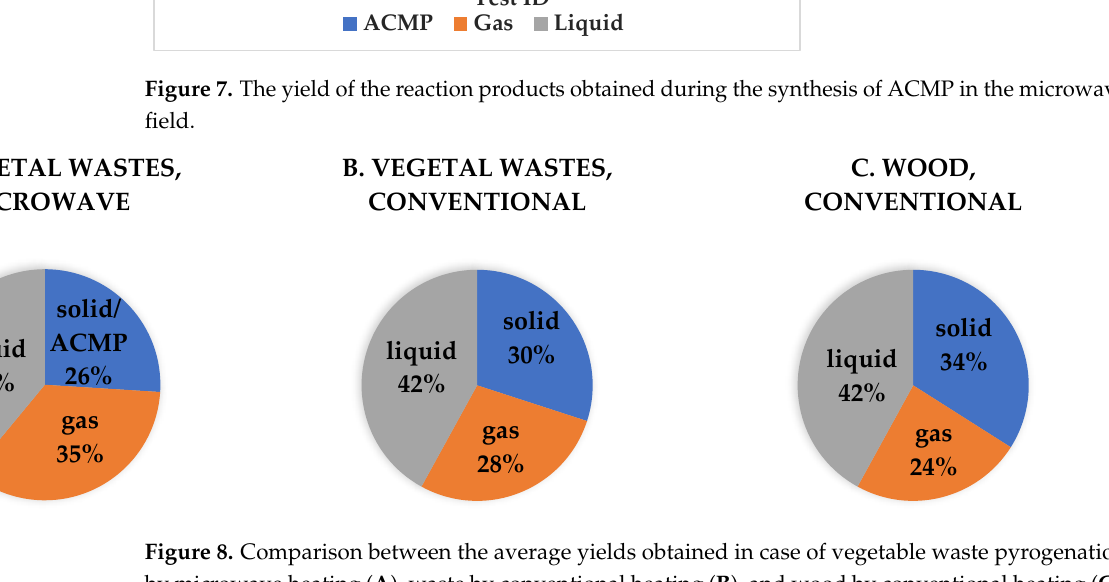
The variation in ash is quite low and is reflected by the small value of the standard deviation, the range varying from a minimum of 1.2% (sample 8), maximum of 3% (sam- ple 4), and an average of 2.2% values. This reveals the feedstock highly suitable for further steps of activation. The average content of volatile matter of 8.52% reveals the adequate degree of degas- sing of the material during ACMP synthesis in the microwave field. The recorded values show a significant variation between the minimum value 4.48% for sample 6, and respec- tively the maximum value of 17.51% for sample 1. The values recorded by the fixed carbon vary between 80.32% (sample 1) and 93.43% (sample 6). The average value of 89.28% reveals a substantial enrichment in carbon through pyrogenation, higher than 79% [84] or 74.3% mentioned for agricultural waste by certain publications [85]. Figure 9 shows a strong correlation between the fixed carbon and volatile content (correlation index R 2 = 0.99), Table 2. The values recorded by the real density parameter (g/cm 3 ) vary between 1.4287 g/cm 3 (sample 1) and 1.614 g/cm 3 (sample 6) with an average value of 1.5412 g/cm 3 . The values recorded by the volumetric weight parameter (g/cm 3 ) vary between 0.31 g/cm 3 (sample 5) and 0.389 g/cm 3 (sample 3) with an average value of 0.3558 g/cm 3 . There are also changes of nitrogen, carbon, hydrogen, and oxygen contents against feedstock. Figure 9. ACMP fixed carbon and volatile matter content. 7577798183858789919395 0